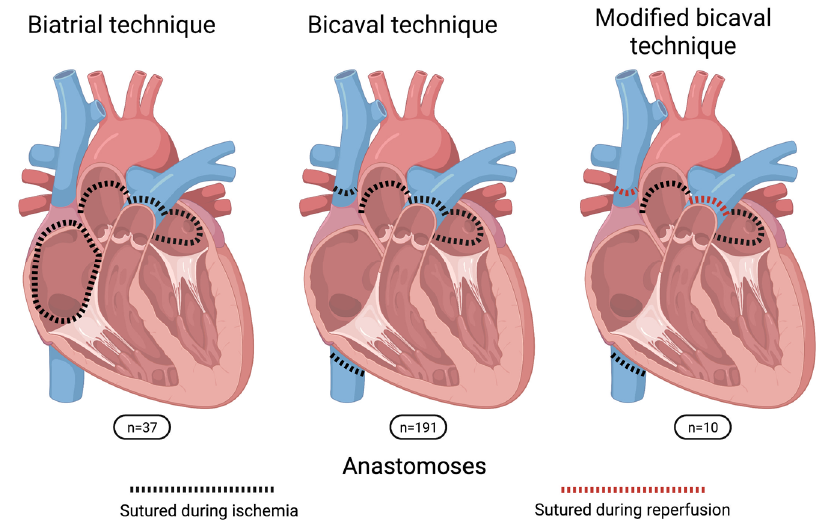
Figure 1. Schematic illustration of sutured anastomoses in comparison of the three different surgical techniques.